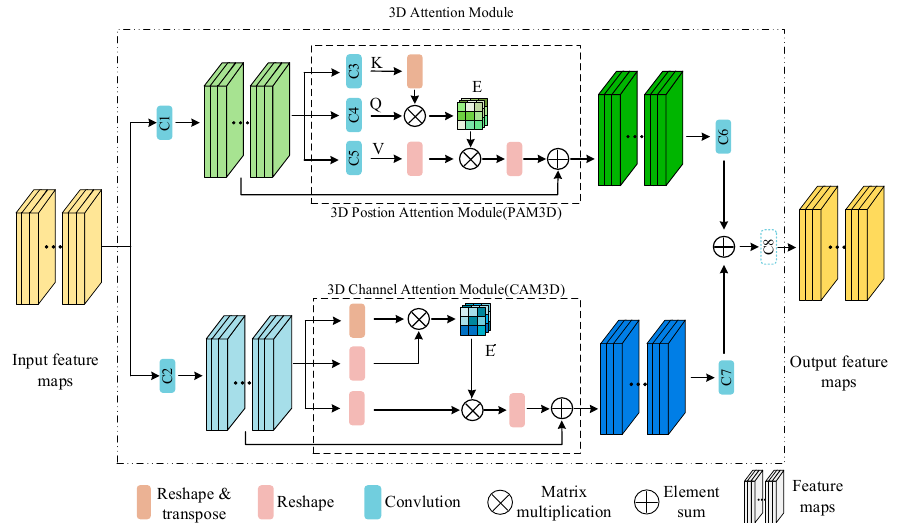
Figure 8. Illustration of the 3D attention module structure. The 3D attention module structure is made up of two branches, the upper branch is the 3D position attention module and the lower one is the 3D channel attention module. E (cid:48) and E are the feature maps with attention weights. In our attention module, the C8 unit, whose original placement position is indicated by the light-blue dashed box, used in [34] is deleted.